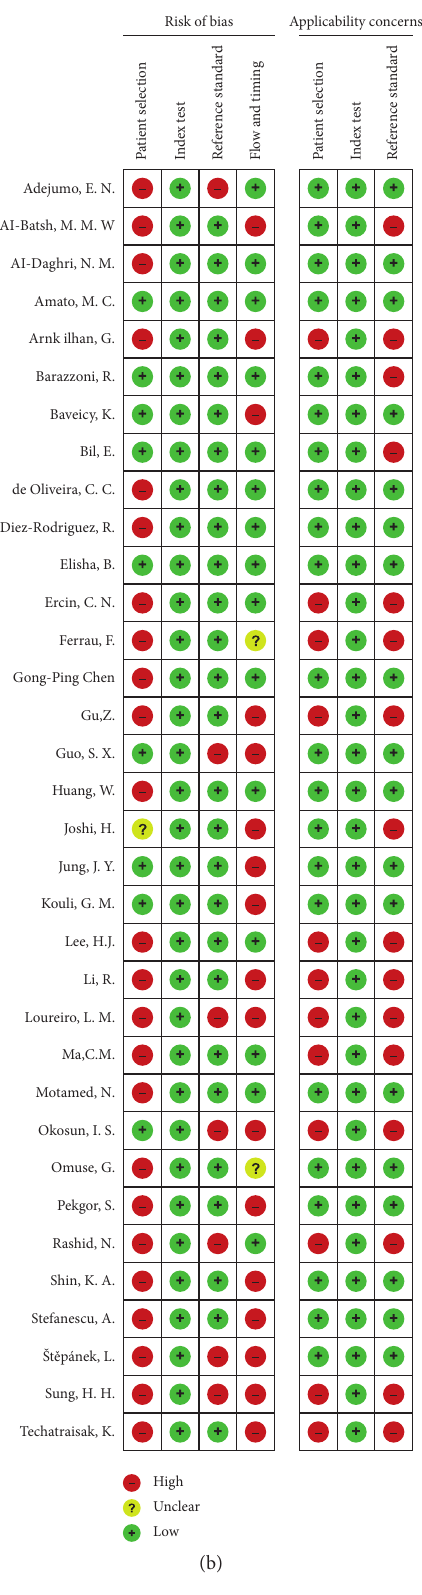
Figure 5: Methodological quality of the included studies. The summary of risk of bias and applicability concerns for the included studies (a) and the quality of individual studies (b) are